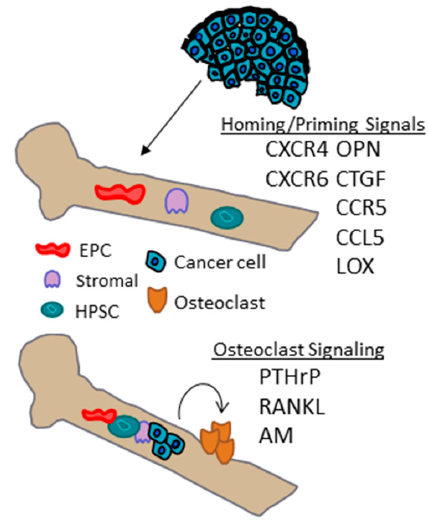
Figure 2. Hypoxia inducible genes that may play a role in bone homing and osteoclast